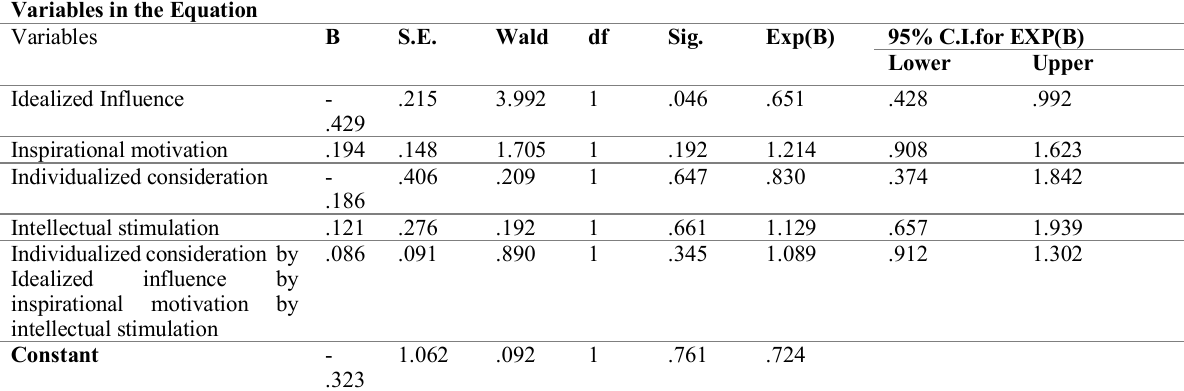
Table 9: FC m-health applications adoption and moderating role of transformational leadership style of hospitals’ management boards in Kenya Variables in the